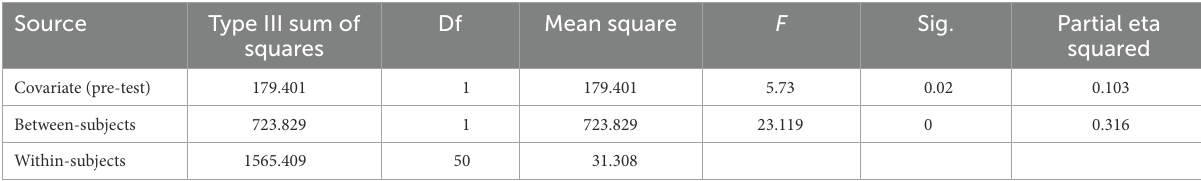
TABLE 4 The results of ANCOVA on writing